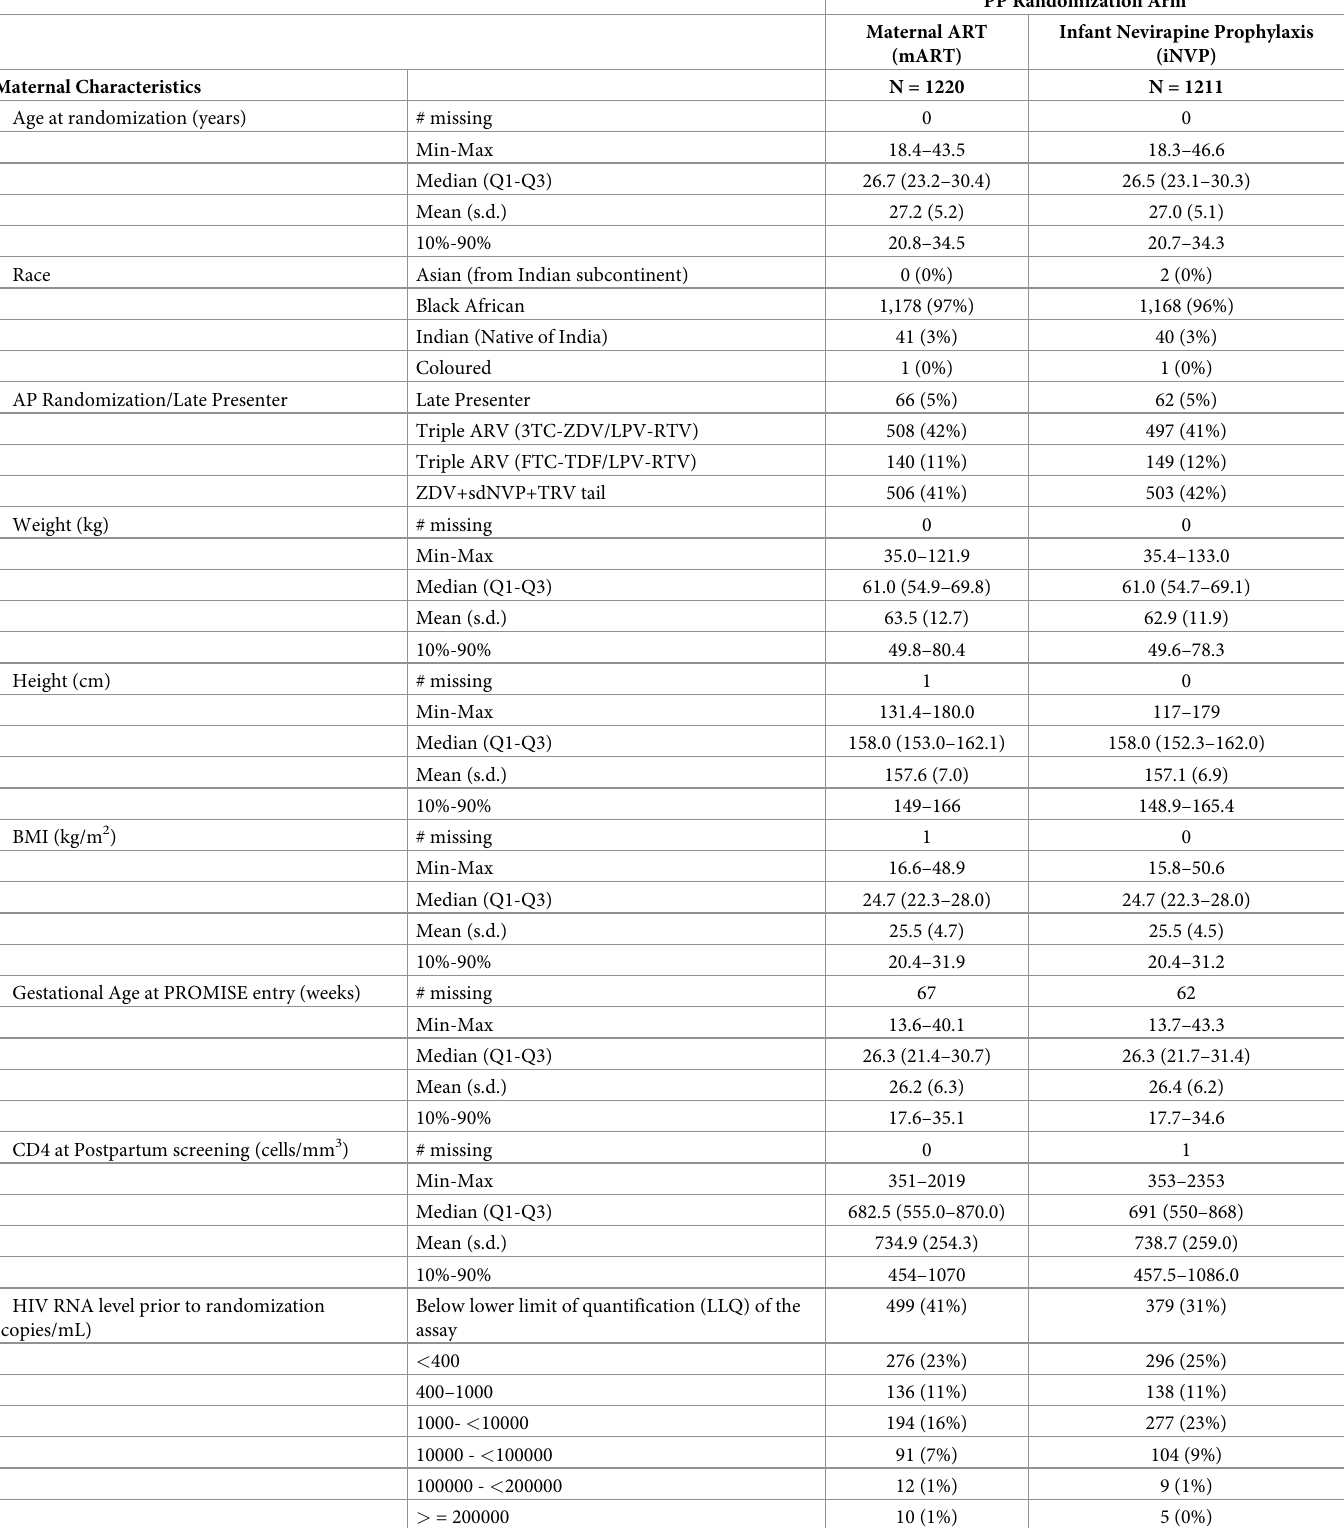
Table 1. Baseline characteristics for maternal and infant participants in the Postpartum